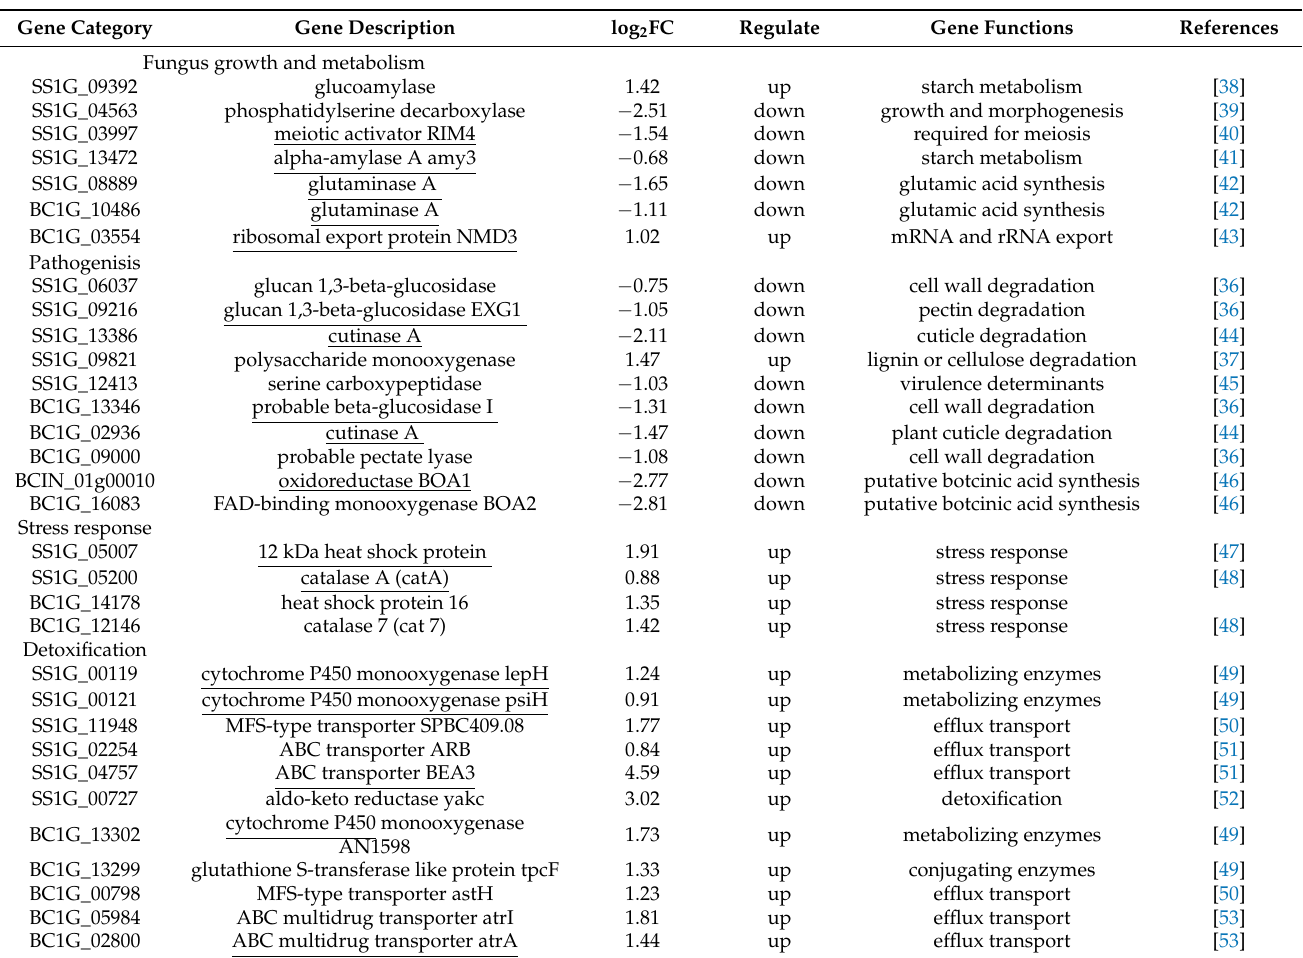
Table 1. A general table showing critical DEGs involved in fungus growth and metabolism, pathogenicity, stress response and detoxification induced by ε